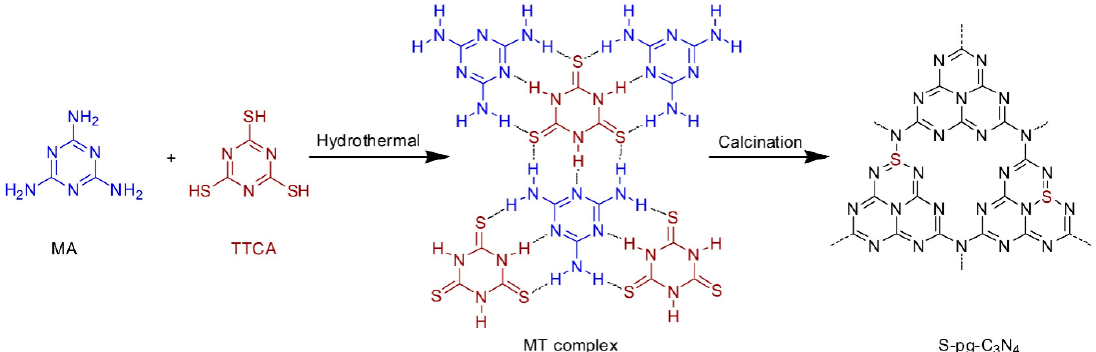
Figure 7. Scheme of the formation of melamine-trithiocyanuric acid (MT) complex and S-g-C 3 N 4. Reprinted from [95] Copyright (2017), with permission from Elsevier.